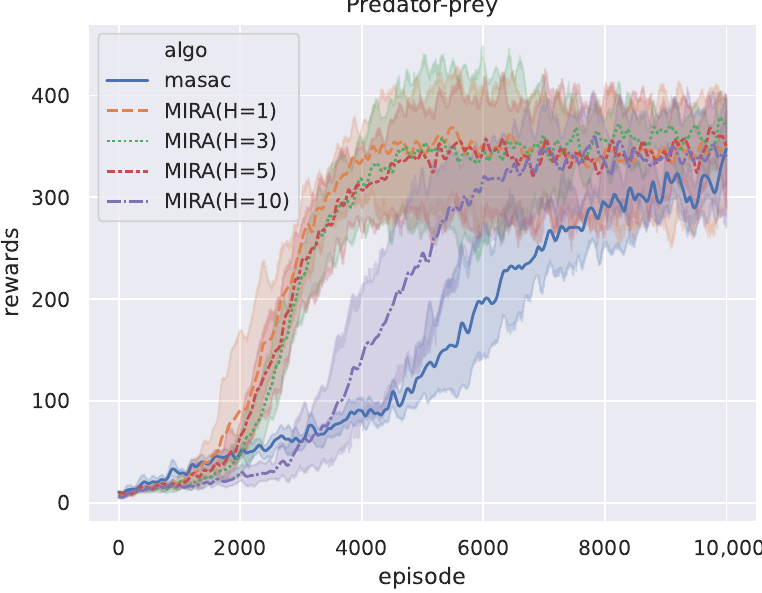
Figure 9. MIRA training curves for various values of the rollout